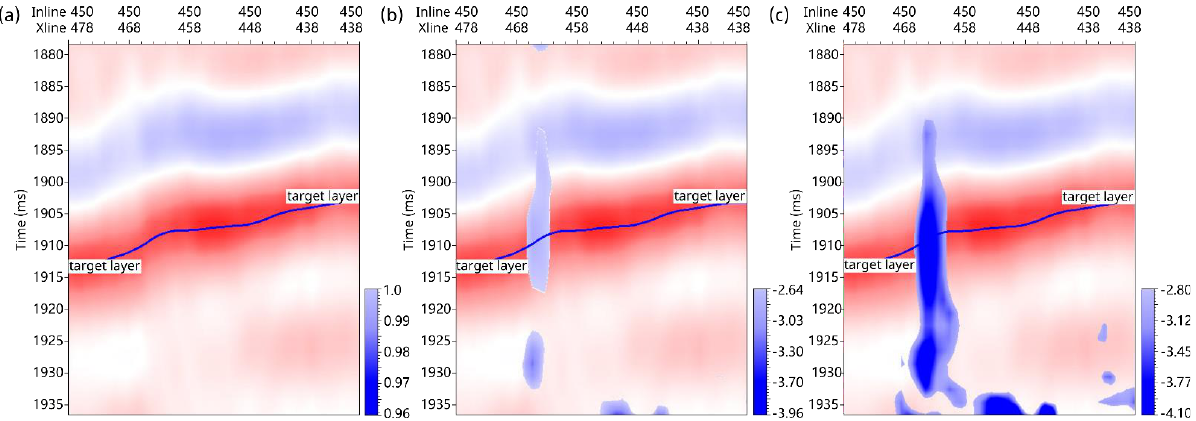
Figure 5. Different attributes crossed line 1. ( a ) Amplitude vs. coherence, ( b ) amplitude vs. PC , ( c ) amplitude vs. PC (new method).